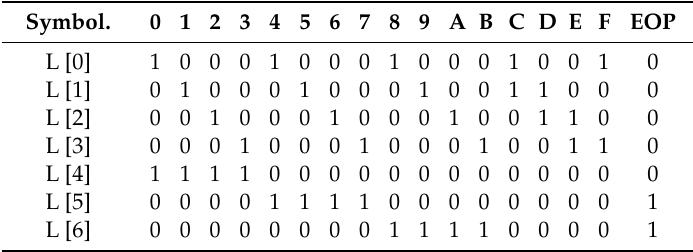
Table 4. 2-of-7 coding: converting a symbol into 2 changing bits. ‘1 (cid:48) and ‘0 (cid:48) do not represent physical voltage levels corresponding to logical-1 and logical-0, but symbolise change of state (‘1 (cid:48) ) or no change of state (‘0 (cid:48) ). If less confusing, the symbol ‘C’ could be used for change and ‘N’ for no-change, to encode ‘1 (cid:48) and ‘0 (cid:48) .